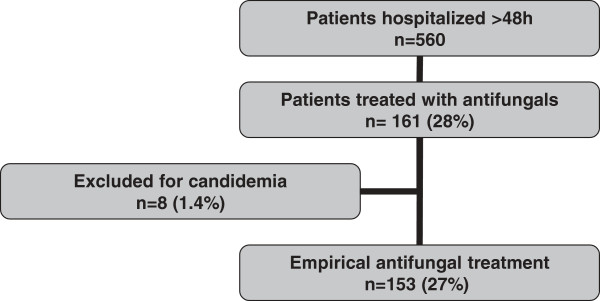
Study flowchart.